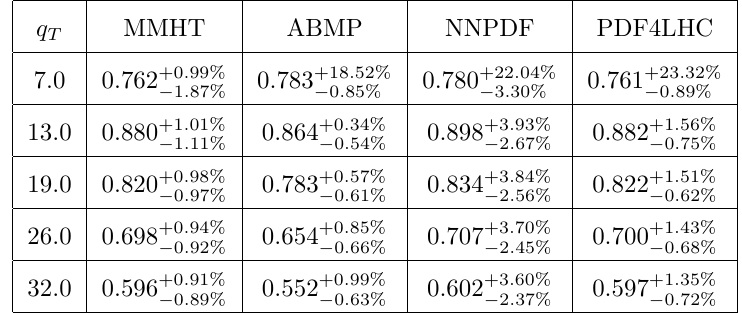
Table 2 . q T distributions at NNLO A +NNLL using di(cid:11)erent PDF sets along with